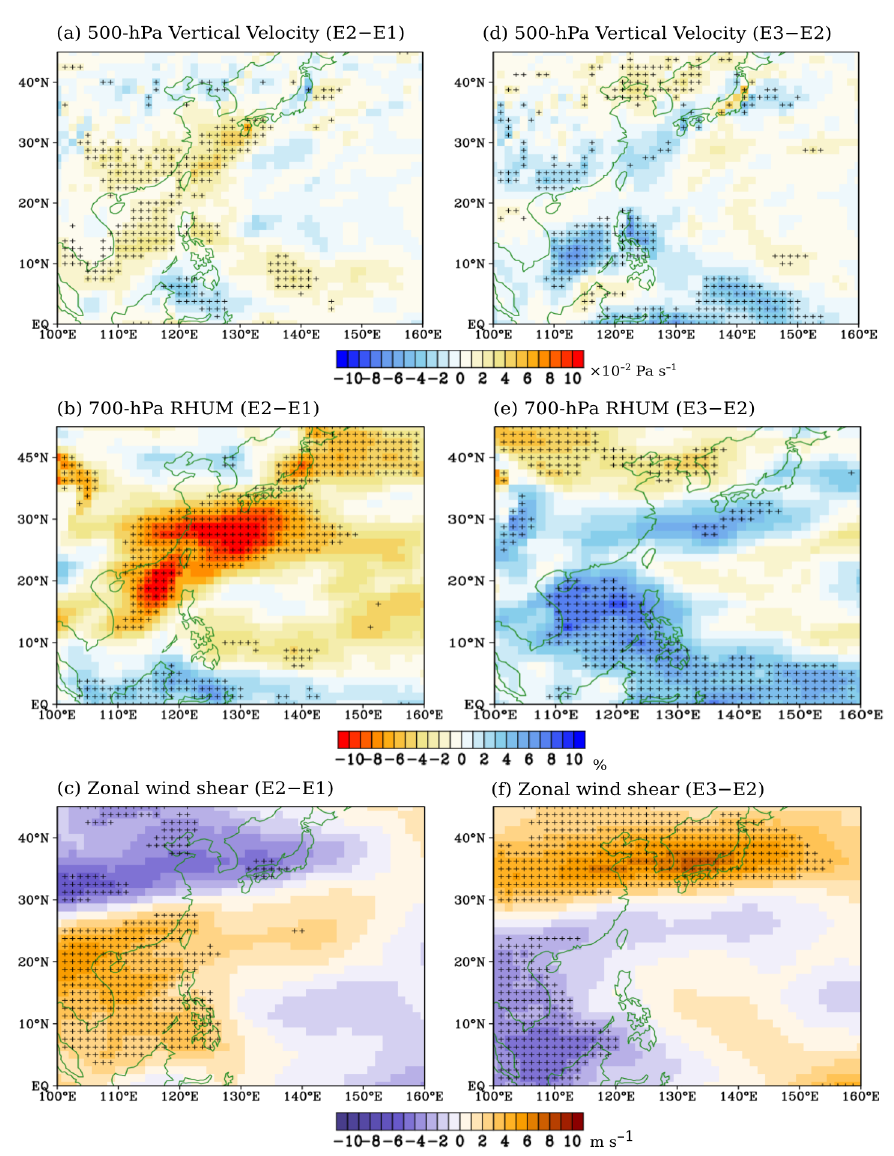
Figure 9. Epochal difference in 500-hPa vertical velocity ( × 10 − 2 Pa s − 1 ; a , d ), 700-hPa relative humidity ( RHUM ; %; b , e ); and vertical zonal wind shear ( U 200hPa minus U 850hPa ; m s − 1 ; c , f ) during December. Figure 9 a – c are the differences between E1 (1961–1976) and E2 (1977–1992) (E2 minus E1). Figure 9 d – f are the differences between E2 and E3 (1993–2008) (E3 minus E2). Cross markings indicate statistical significance above the 90% confidence level using the t ‐ test.